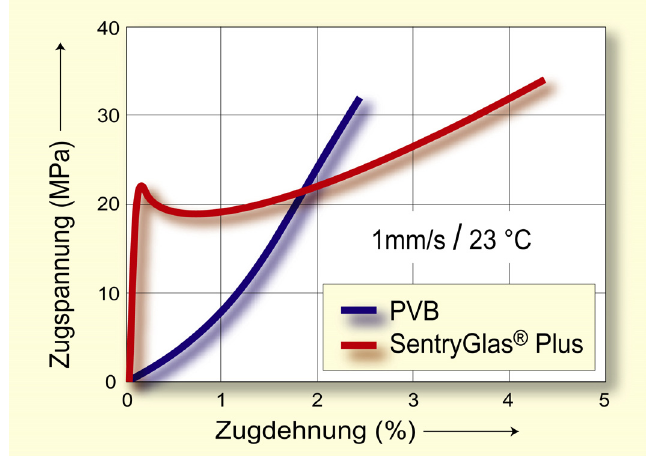
Figure 2: Comparison of short-term of PVB and SentryGlas® interlayers stiffness and strength